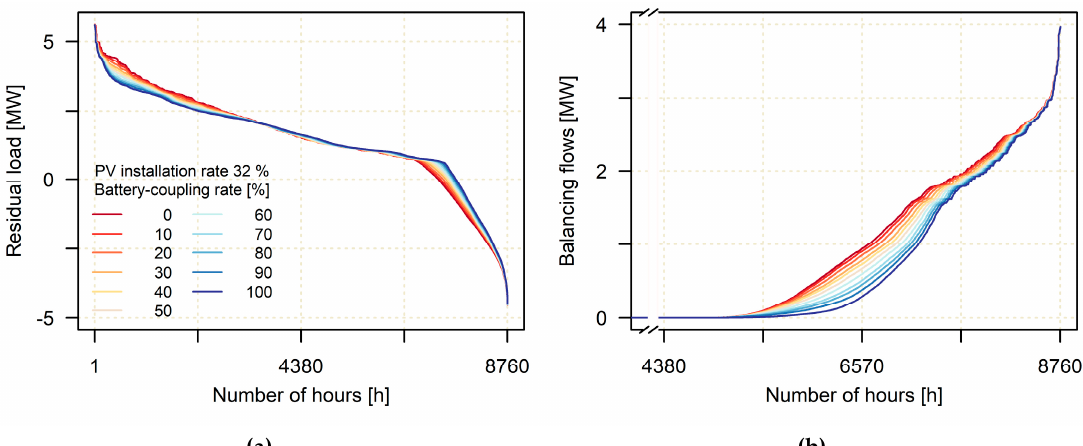
Figure 7. Duration curves of ( a ) residual loads and ( b ) balancing flows for different battery-coupling rates at a PV installation rate of 32%.